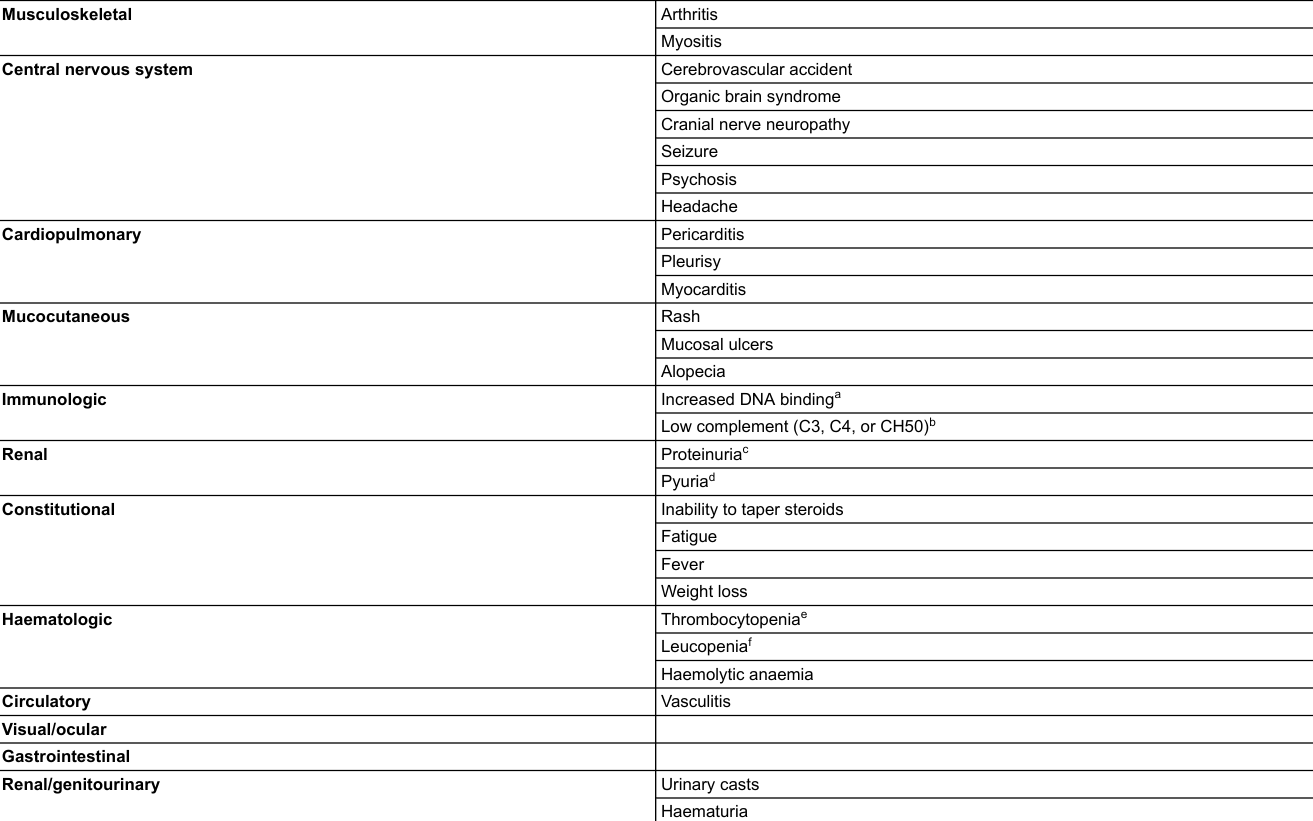
Table S2: Pre-defined clinical manifestations of SLE listed in the Patient Case Report Form.